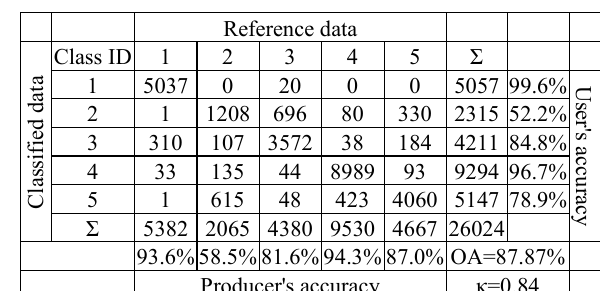
Figure 5. RF classification results of the example subset based on the: (a) S-2, (b) PS and (c) fused imagery